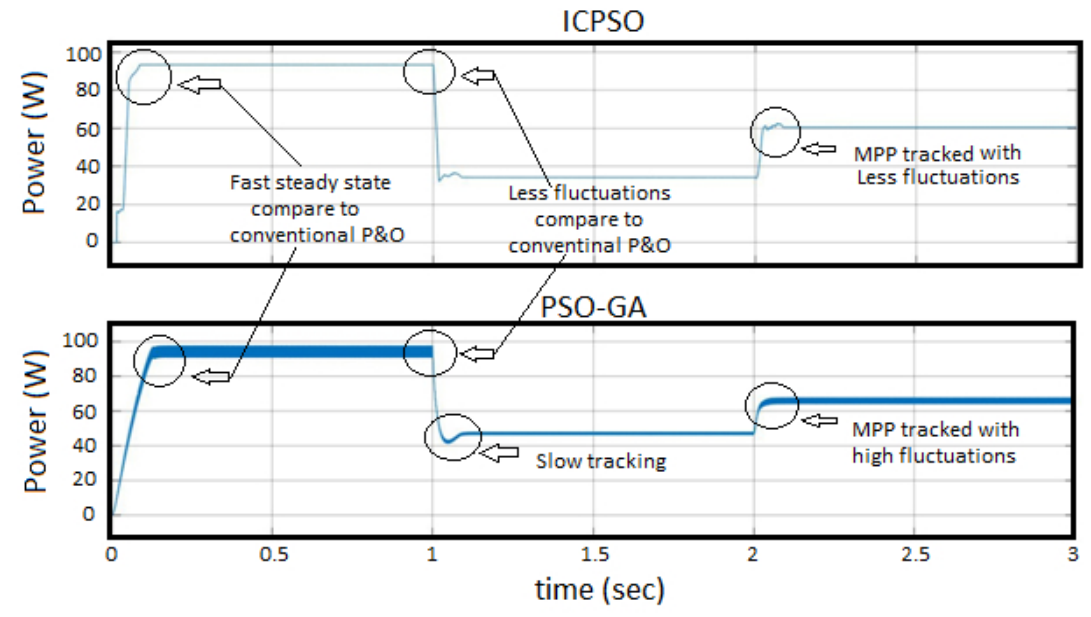
Figure 11. Comparative analysis of I&C algorithm and proposed ICPSO algorithm. Table 1. Comparative performance analysis under variable irradiance and constant temperature level.